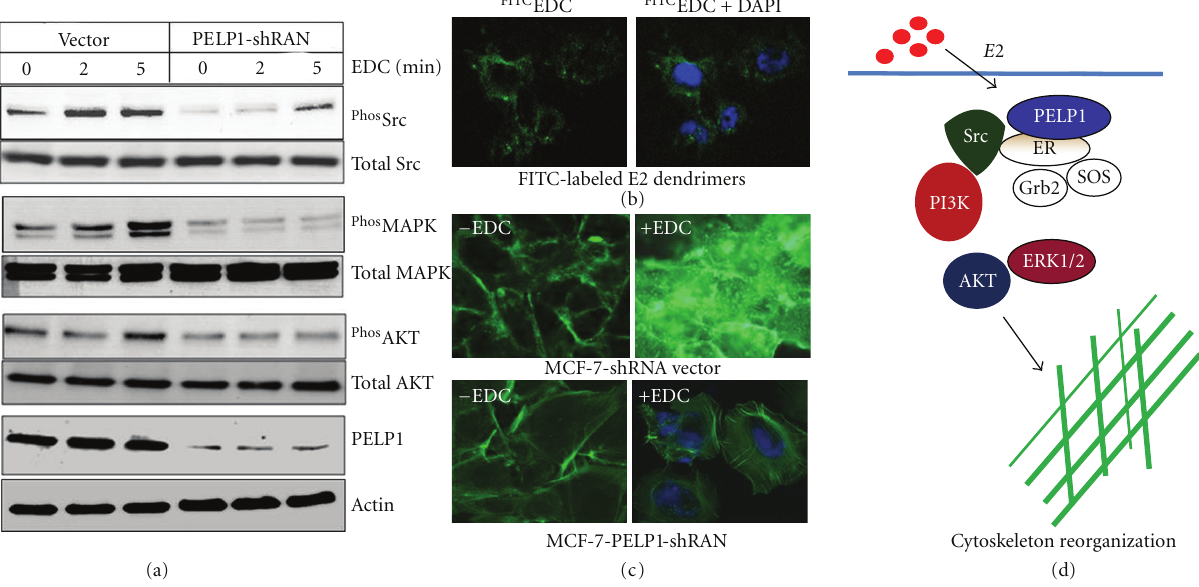
Figure 1: ER-extranuclear signaling promotes actin reorganization via ER coregulator PELP1. (a) MCF7 shRNA vector control and MCF7- PELP1-shRNA cells were cultured in 5% DCC serum containing medium treated with or without estrogen dendrimers (EDC). The activation of signaling pathways was analyzed by Western blotting of total protein lysates with phospho-specific antibodies. (b) MCF7 cells were treated with FITC-labeled EDC and localization of EDC was analyzed by confocal microscopy . Green; EDC; Blue, DAPI. (c) MCF7 or MCF7-PELP1- shRNA cells were treated either with E2 or EDC and the F-actin status was analyzed by phalloidin staining and visualized by confocal microscopy. (d) Schematic representation of estrogen-mediated extranuclear signaling. Adapted from